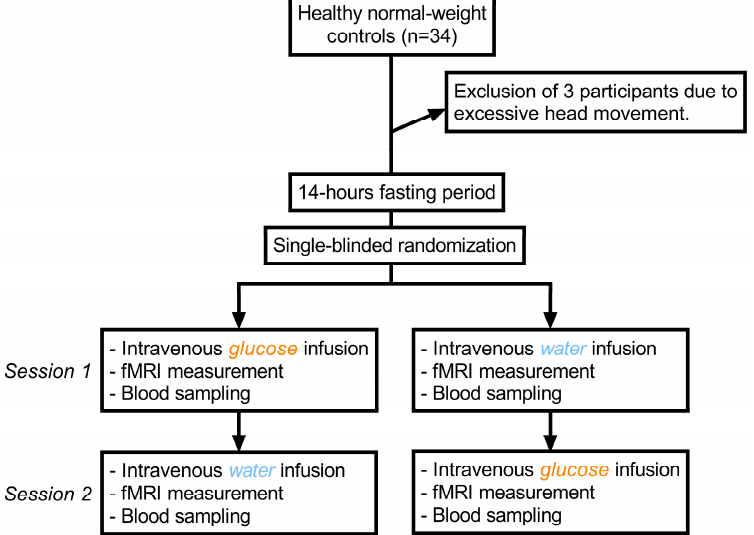
Figure 5. Graphical depiction of the study protocol.